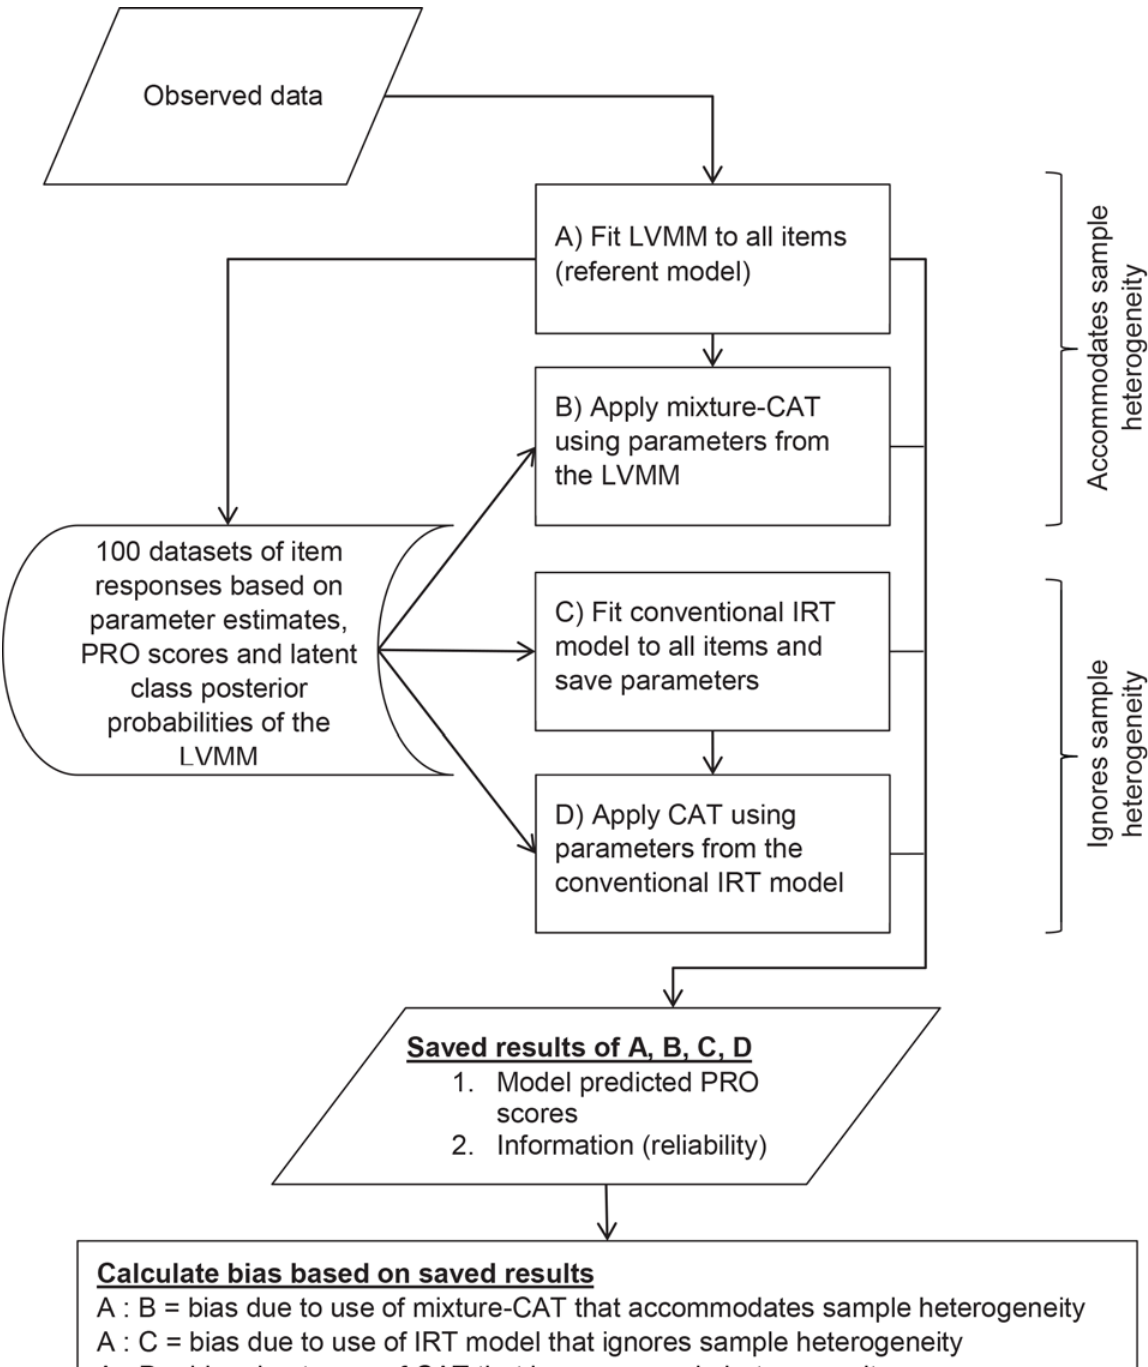
Fig 1. Flowchart of simulation